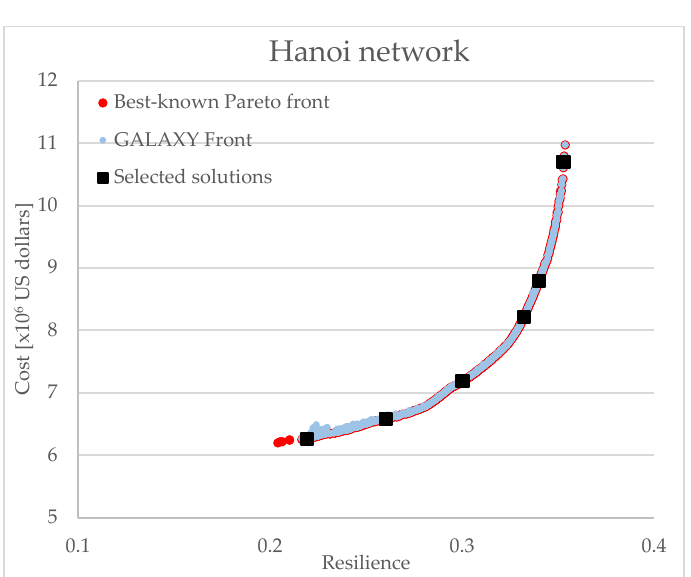
Figure 4. Pareto fronts of the HAN.